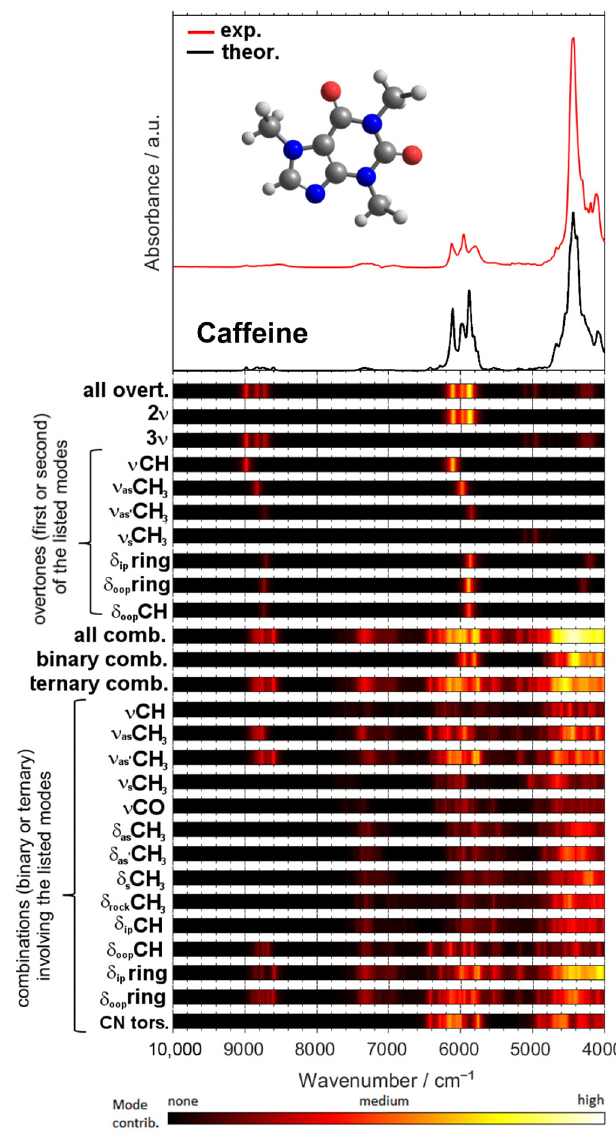
Figure 6. Vibrational modes’ contribution to NIR spectrum of caffeine available from quantum chemical calculations. Reproduced (CC-BY 4.0 license) from [93].